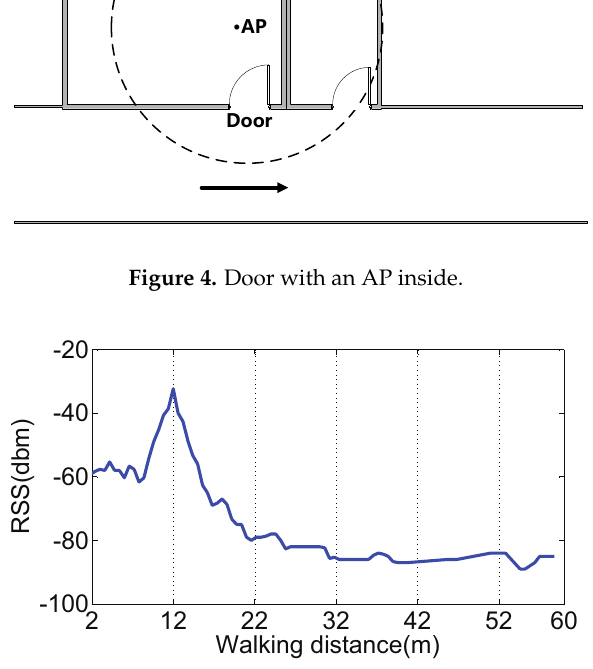
Figure 5. RSS variations when passing by a door.